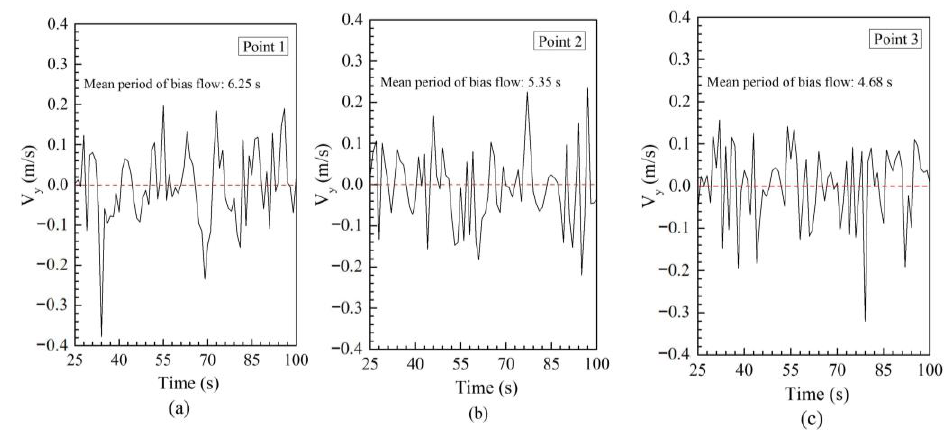
Figure 14. Time history of velocities at monitor points at conditions of ( a ) 310 A/0.5 Hz, ( b ) 310 A/1.5 Hz, and ( c ) 310 A/2.5 Hz.